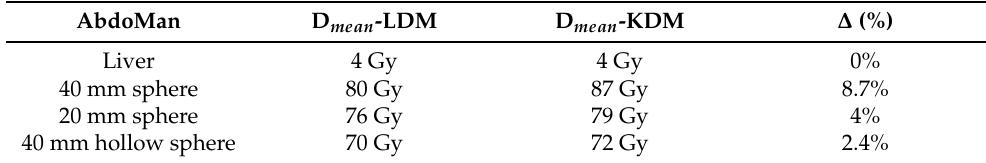
Table 2. Lesions and liver mean activity within the AbdoMan phantom obtained by means of the LDM and DKM.